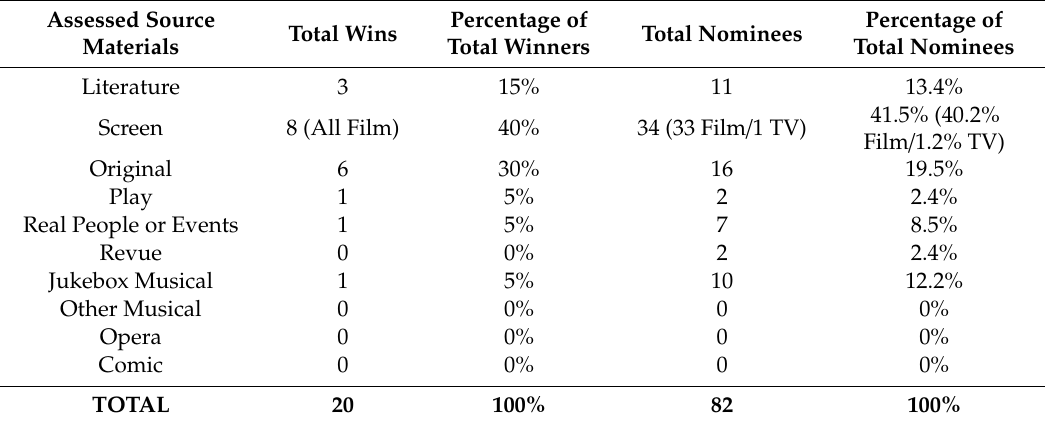
Table 2. Comparative overall statistics of source materials